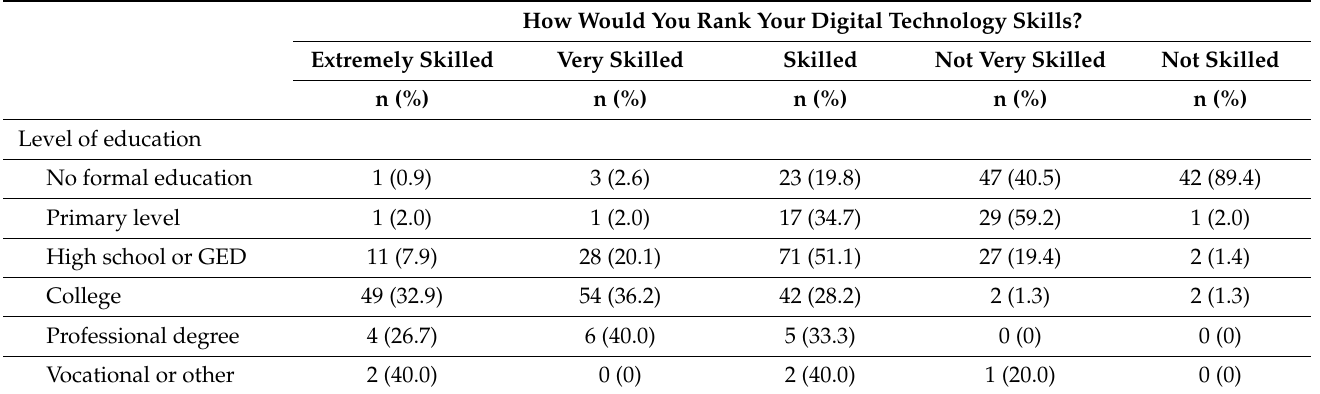
Table 2. Digital technology skills by educational level of participants (N = 473).